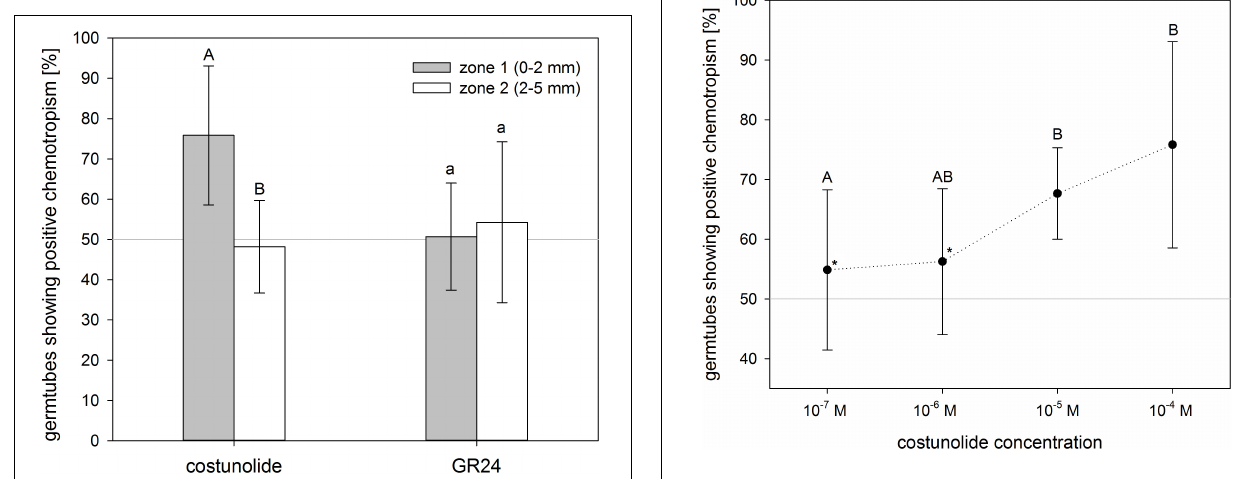
FIGURE 4 | Distance-depending reaction of O. cumana germ tubes on costunolide. Germ tubes of seeds placed closer to the substance source showed significantly higher chemotropism percentages toward costunolide (10 − 4 M) but not toward GR24 (3.3 × 10 − 6 M). Means ± standard deviation of n = 5–7 replications. Same letter indicates that differences are not statistically significant (Tukey test, p < 0.05).